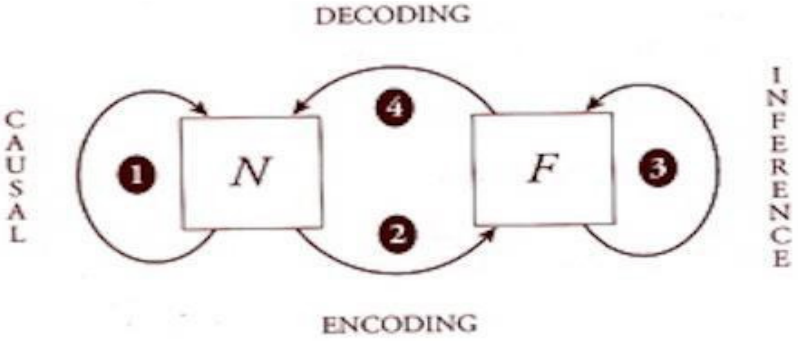
Figure 1. Robert Rosen’s Modeling Relation Diagram.